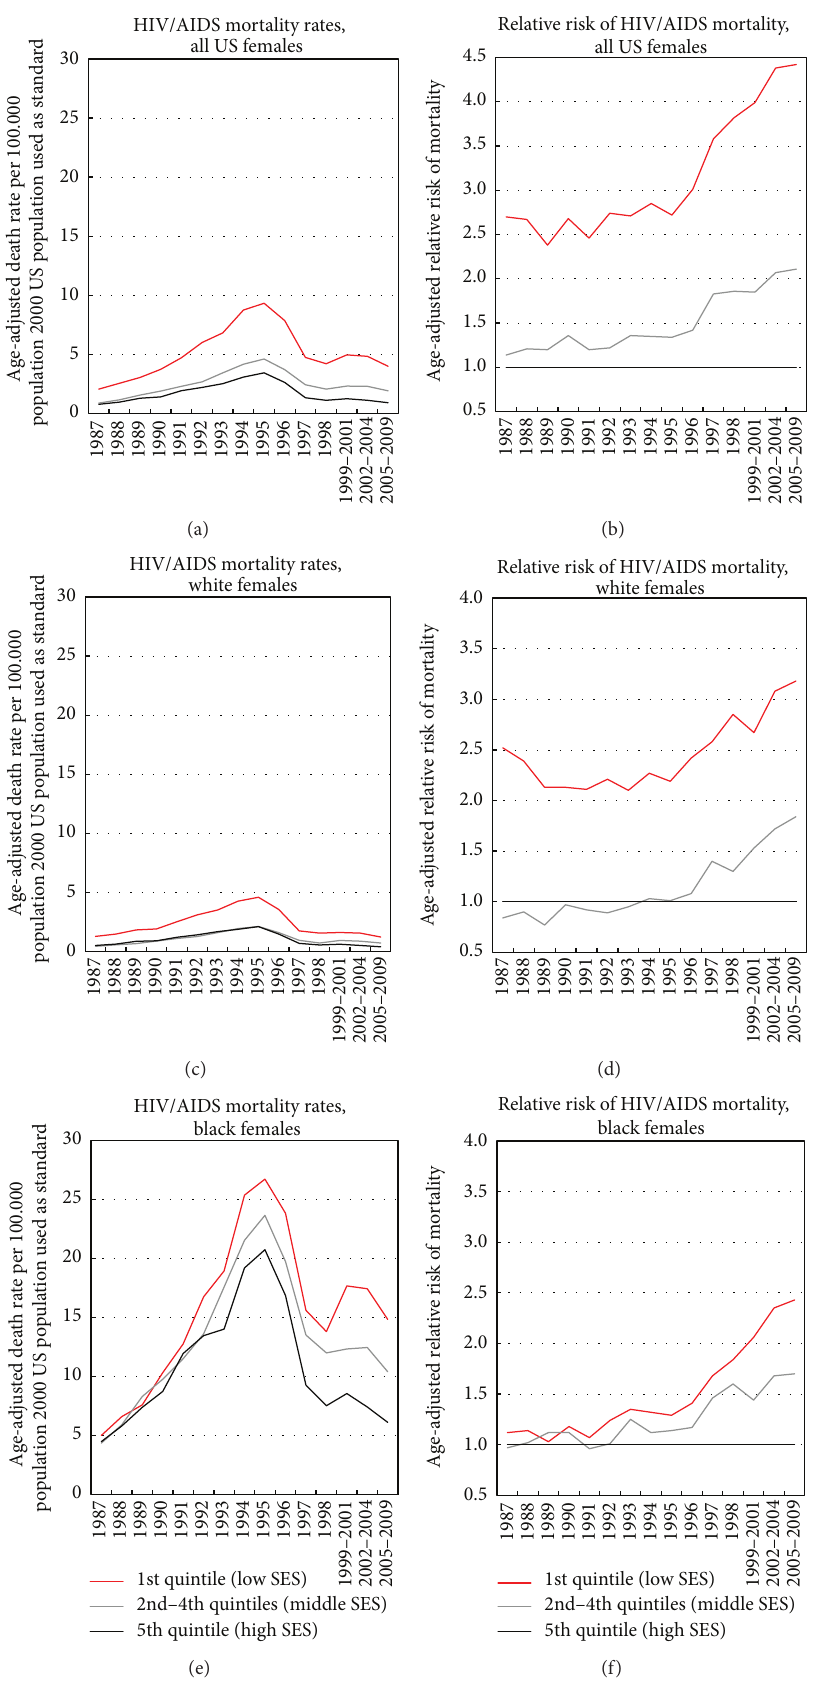
Figure 5: Trends in race-specific HIV/AIDS mortality by area socioeconomic deprivation, US females,